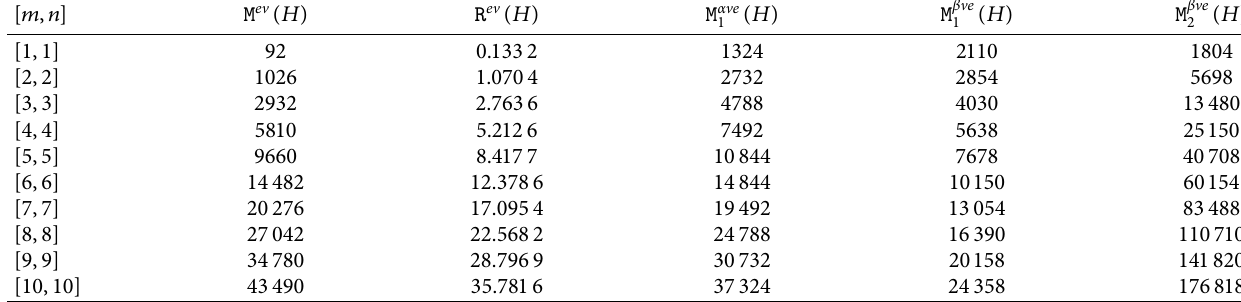
Table 4: Numerical results of indices for vanadium carbide.